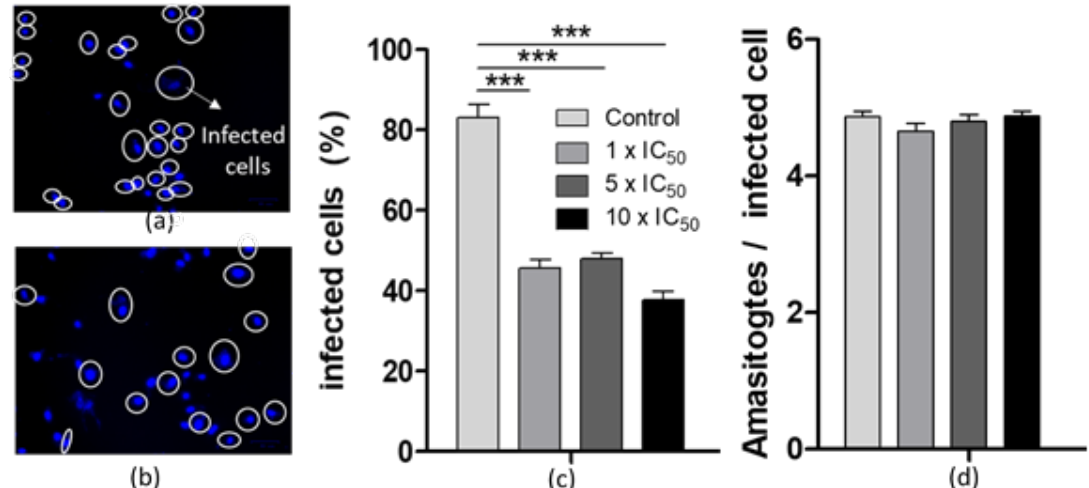
Figure 4. Effect of [V V O(IN-2H)(L2-H)] on the infection process after 24 h post-incubation. Infection established with ( a ) untreated cell-derived trypomastigotes (control); ( b ) 1 × IC 50 treatment. White circles show infected cells (Infected cells were stained with DAPI and counted for each treatment). ( c ) Percentage of infected cells using pretreated cell-derived trypomastigotes. Comparison of infected cell percentages with control untreated cell-derived trypomastigotes (control) was performed using the one-way ANOVA test, followed by the Bonferroni post hoc test. ( d ) Number of amastigotes per infected cell after 24 h of incubation with the indicated concentrations of the complex. The mean and SD are shown for each condition. Three independent experiments were performed. In each experiment, at least 300 cells were counted. ANOVA test: *** = P < 0.001.